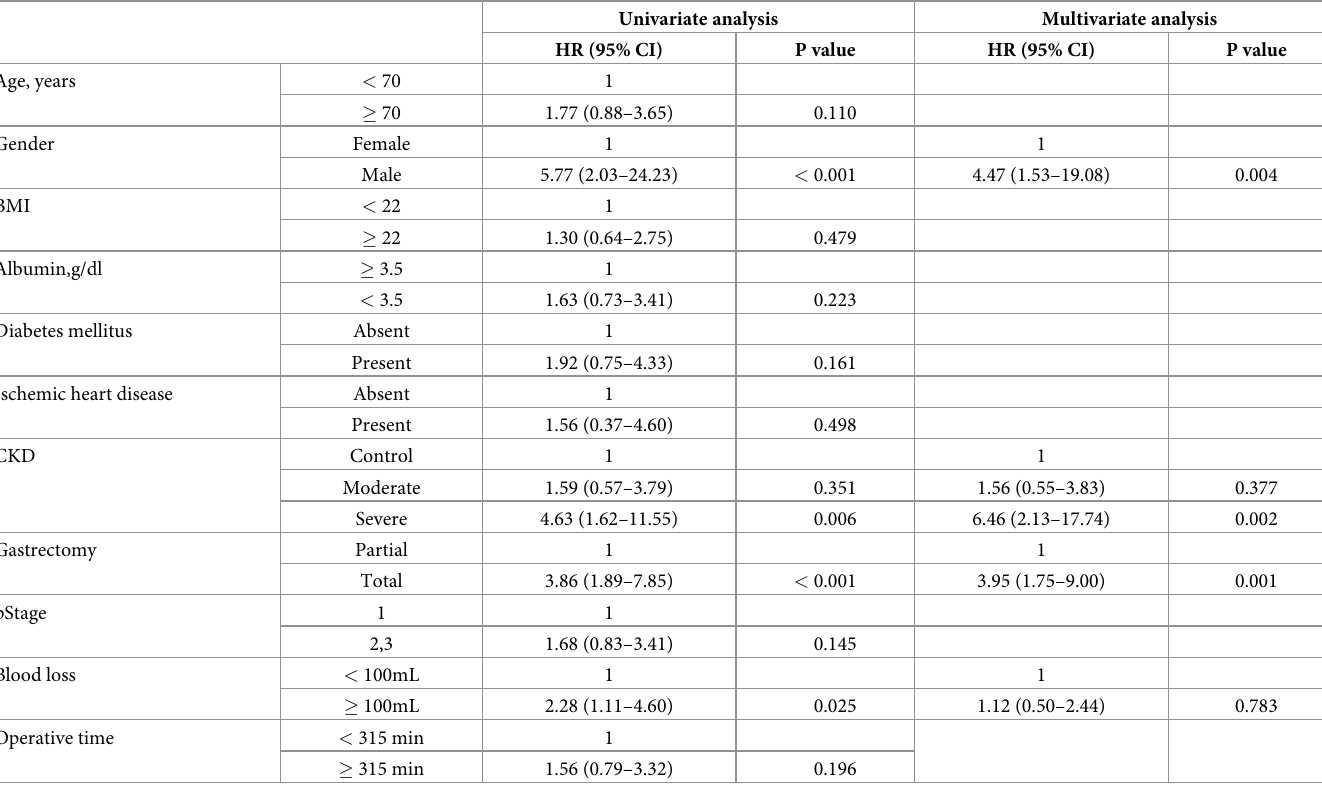
Table 3. Uni- and multivariate analysis of the risk factors of anastomotic leakage.